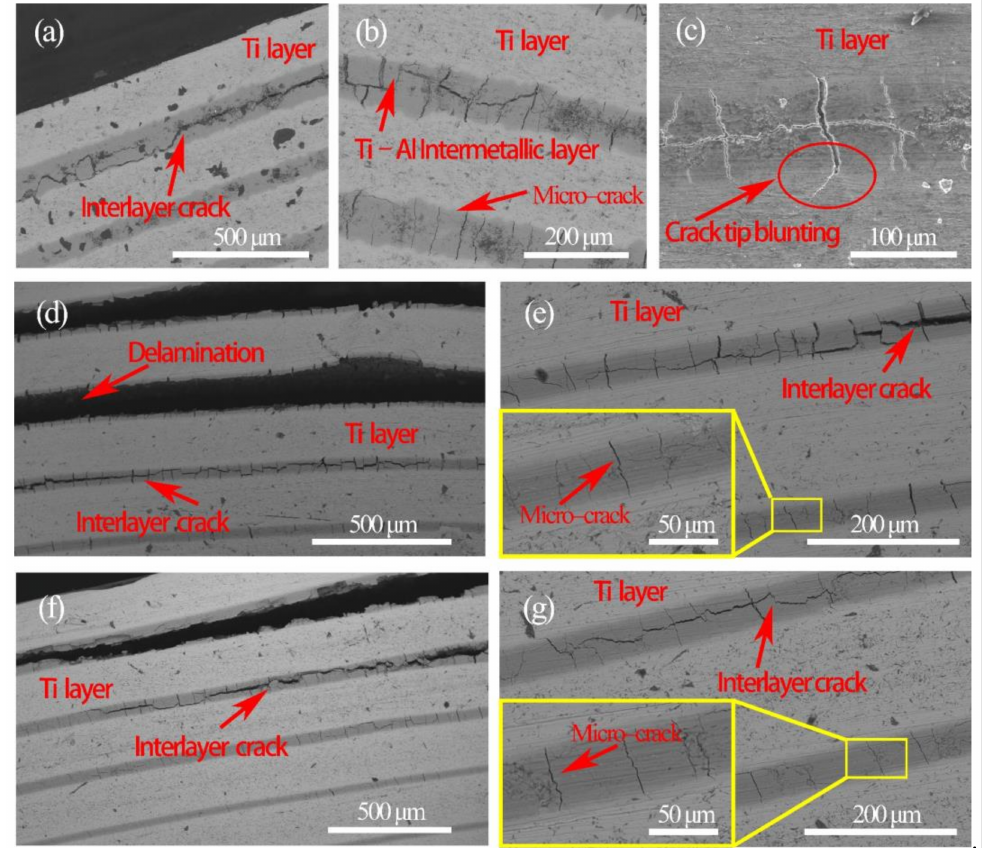
Figure 18. The crack morphologies of the prepared laminated composites in three-point bending test: ( a – c ) Ti/ Ti–Al Laminated Composite; ( d – g ) SiC f -reinforced Ti/ Ti–Al laminated composites, ( d ) and ( e ) Pattern A stressed in tension, ( f ) and ( g ) Pattern B stressed in